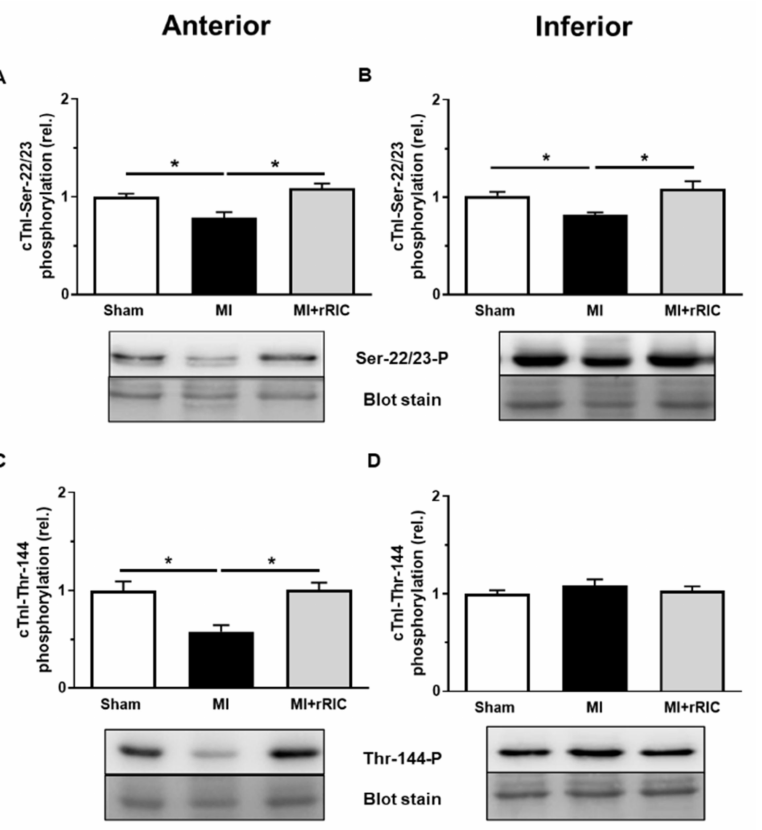
Figure 6. PKA- and PKC-specific phosphorylation of cTnI in the anterior ( A , C ) and inferior ( B , D ) LV regions. Cardiac troponin-I (cTnI) phosphorylation levels at the PKA-specific serine-22/23 (Ser-22/23-P) ( A , B ) and PKC-specific threonine-144 (Thr-144-P) ( C , D ) residues were screened by Western immunoblotting in Sham, MI, and MI + rRIC groups of anterior and inferior LV areas. The phosphorylation sites of cTnI were labelled with specific antibodies. Total protein amounts were assessed by a super sensitive blot stain. Bars represent means ± SEM (normalized to the mean of the Sham group as control), * p < 0.05, n = 7–10 independent determinations from at least 4–5 different